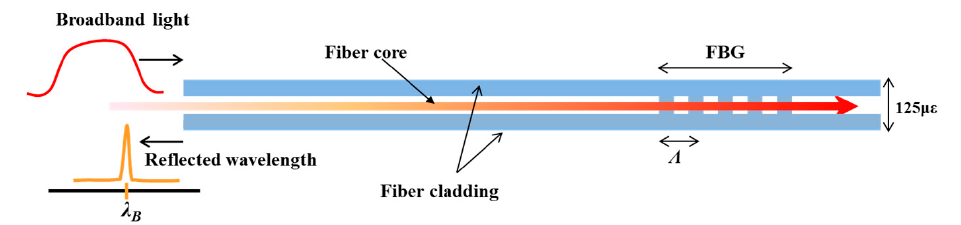
Figure 1. Wavelength filtering by fiber Bragg grating (FBG) sensor.